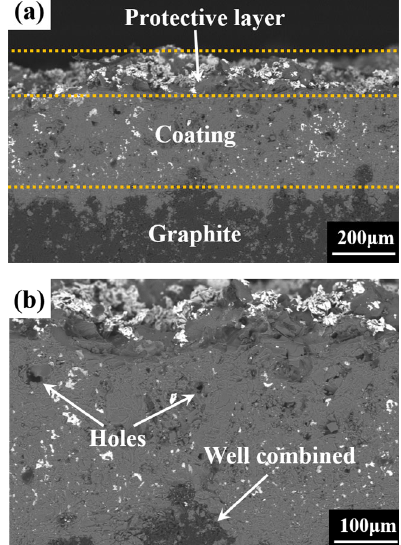
Fig. 10 (a) Cross-sectional SEM micrograph of the TaB 2 –20wt%MoSi 2 –20wt%SiC/SiC coating after TGA tests; (b) magnification of (a).